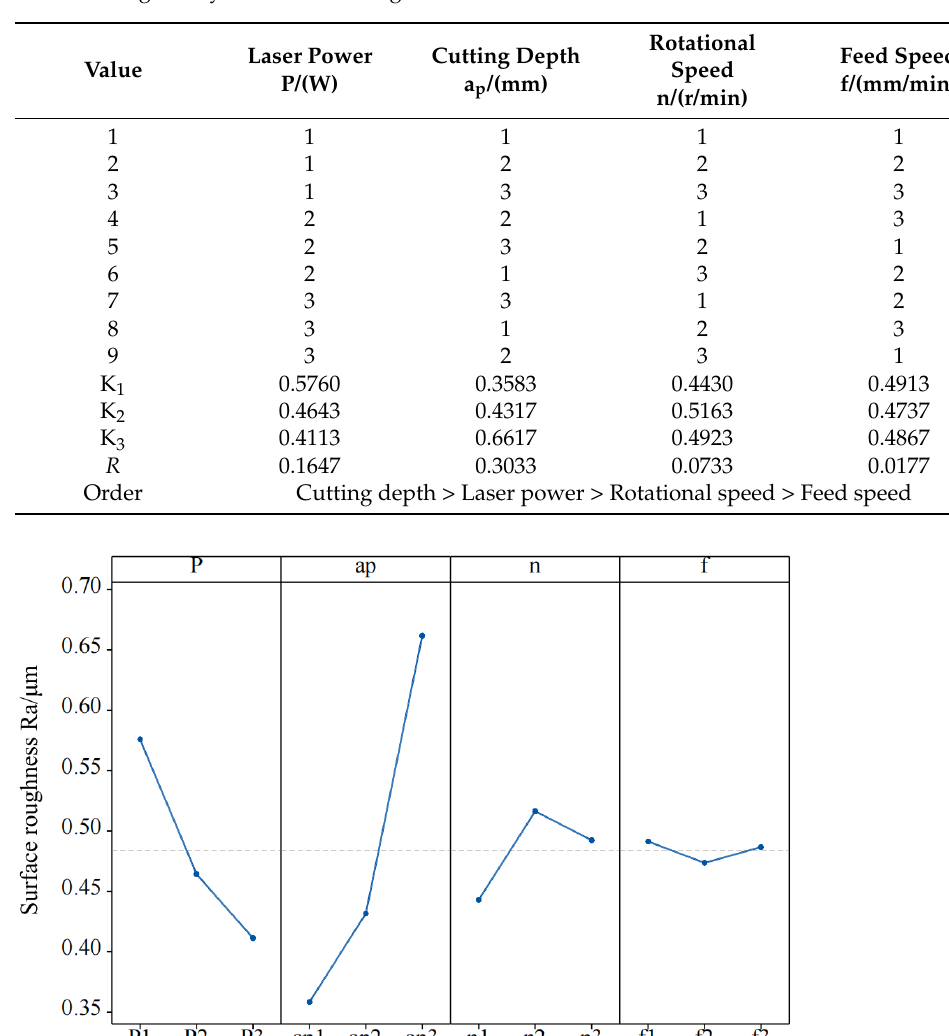
The surface roughness Ra of the processed SiC workpiece was used as the response index, and the results of the BBD experiment are shown in Table 7. Based on the experi- mental results, the regression model equations of laser power, cutting depth, rotational speed, and feed speed with respect to surface roughness are established by Design Expert (Equation